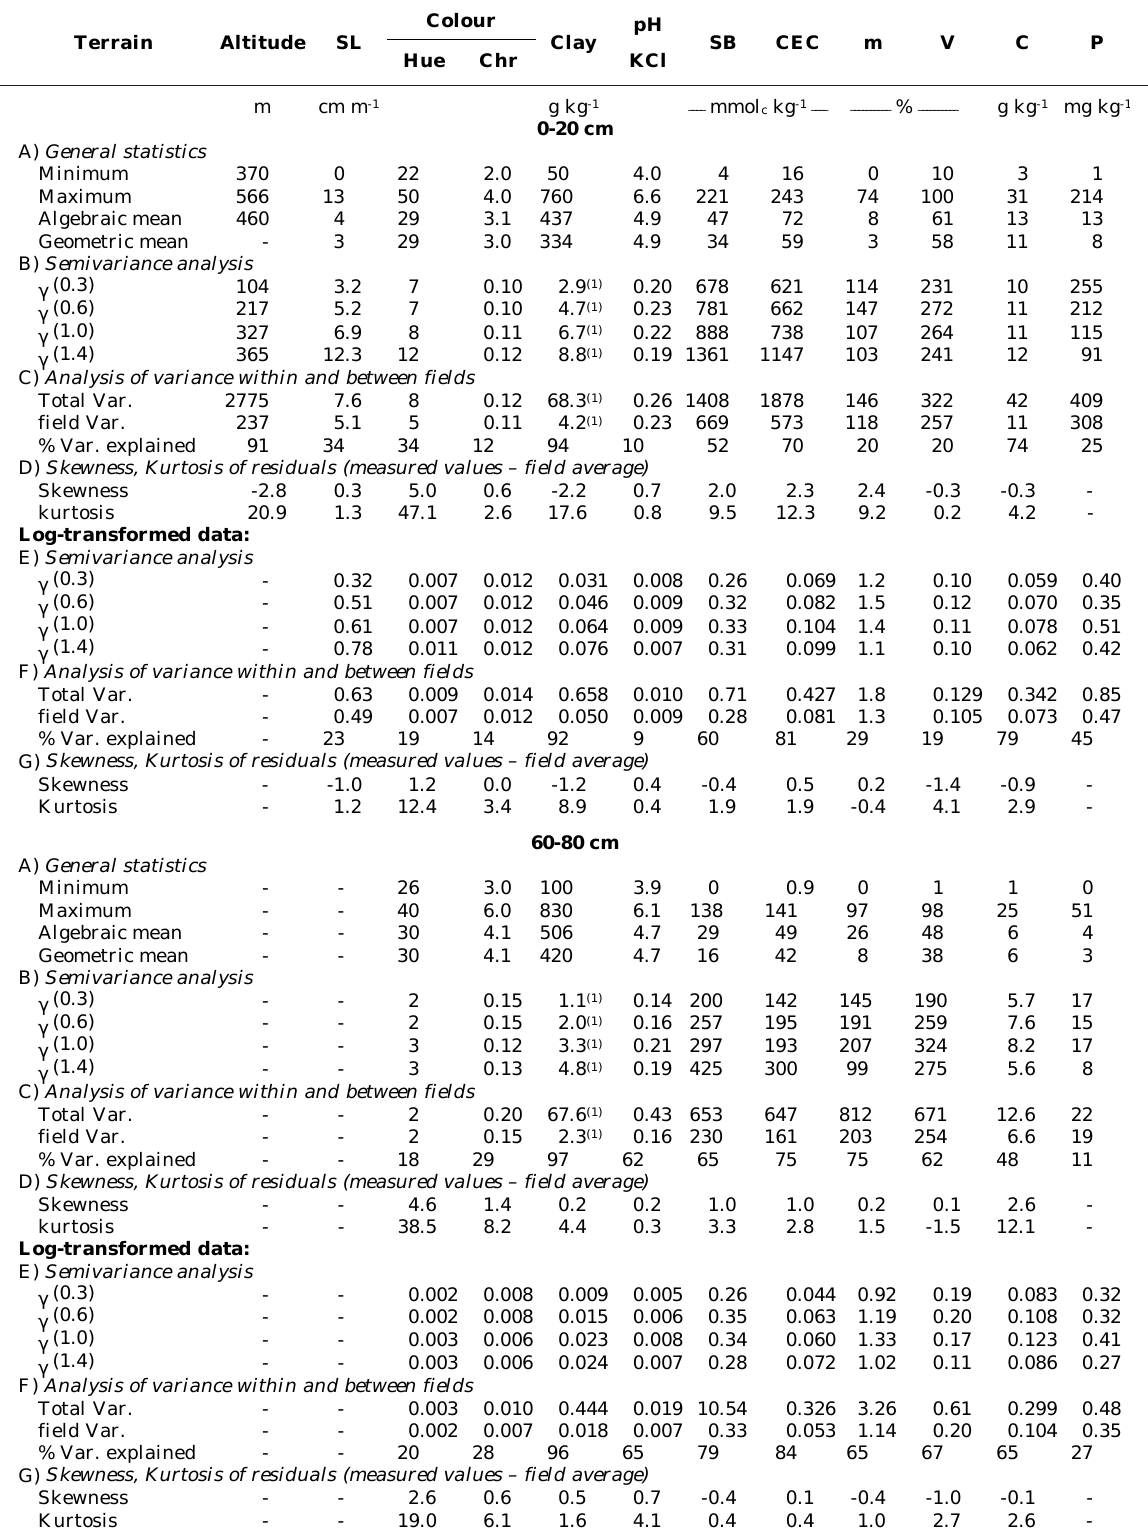
Table 2. Summary of statistical analysis of soil characteristics of sugar cane fields in the Assis region (11 fields, 167 sites)